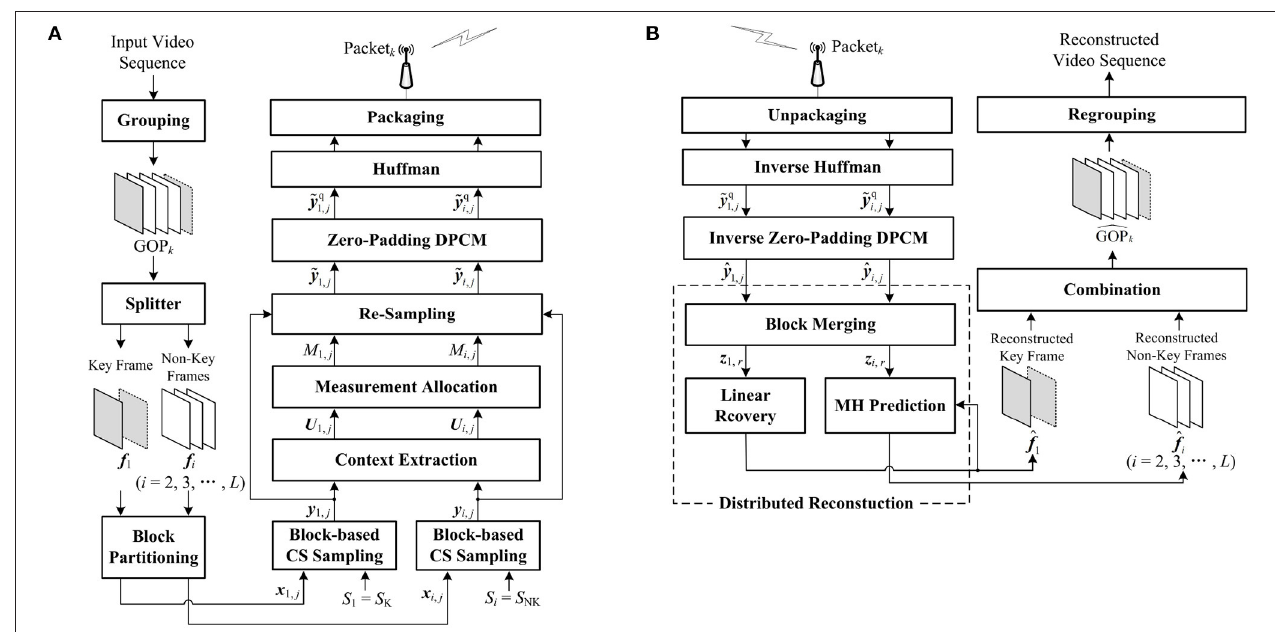
FIGURE 3 | Architecture of the proposed context-based Compressive Video Sensing (CVS) system: (A) encoder framework, (B) decoder framework.